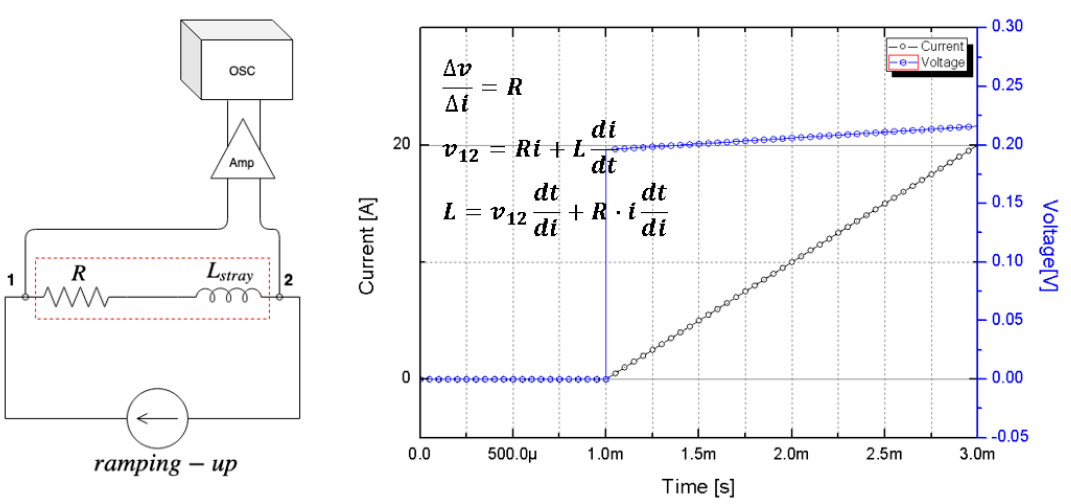
Figure 12. The measurement method for the PCB stray inductance.